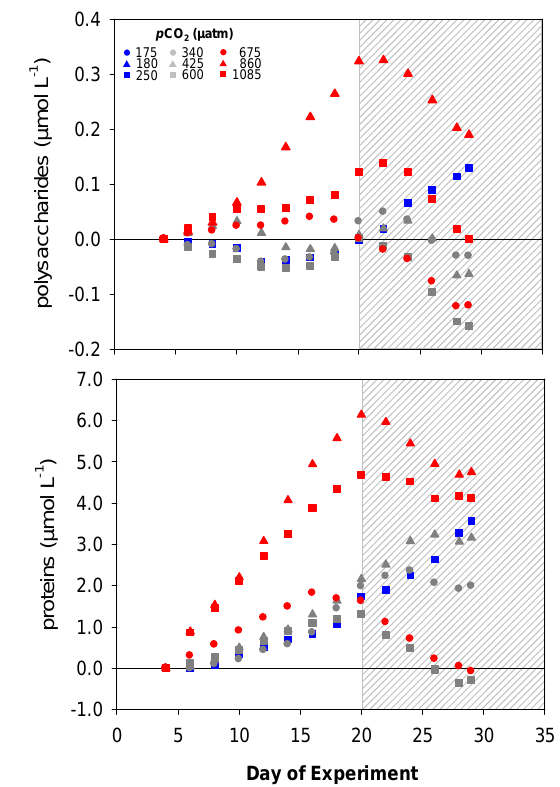
Fig. 6. Temporal development of 1 hydrolysis potential for polysac- charide (upper panel) and protein degradation (lower panel) in acid- ified mesocosms. The shaded area represents the time period after the second chlorophyll a maximum when bacterial abundances in the mesocosms diverged (see text for further explanation).